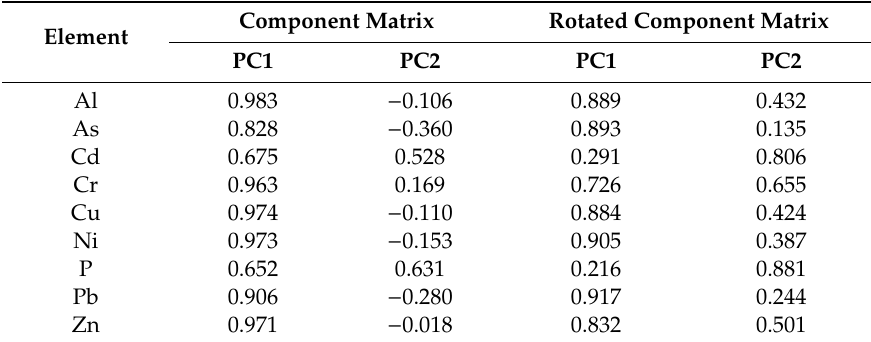
Table 2. The factor loadings of components and that after rotated 1 .